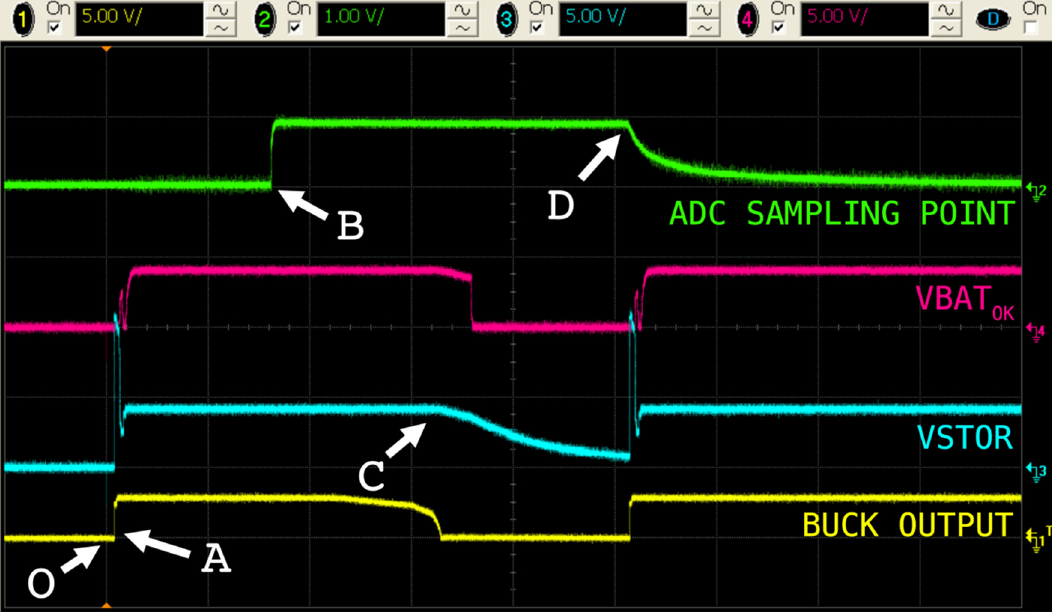
Figure 10. Oscilloscope screenshot: Switching between modes of operation.